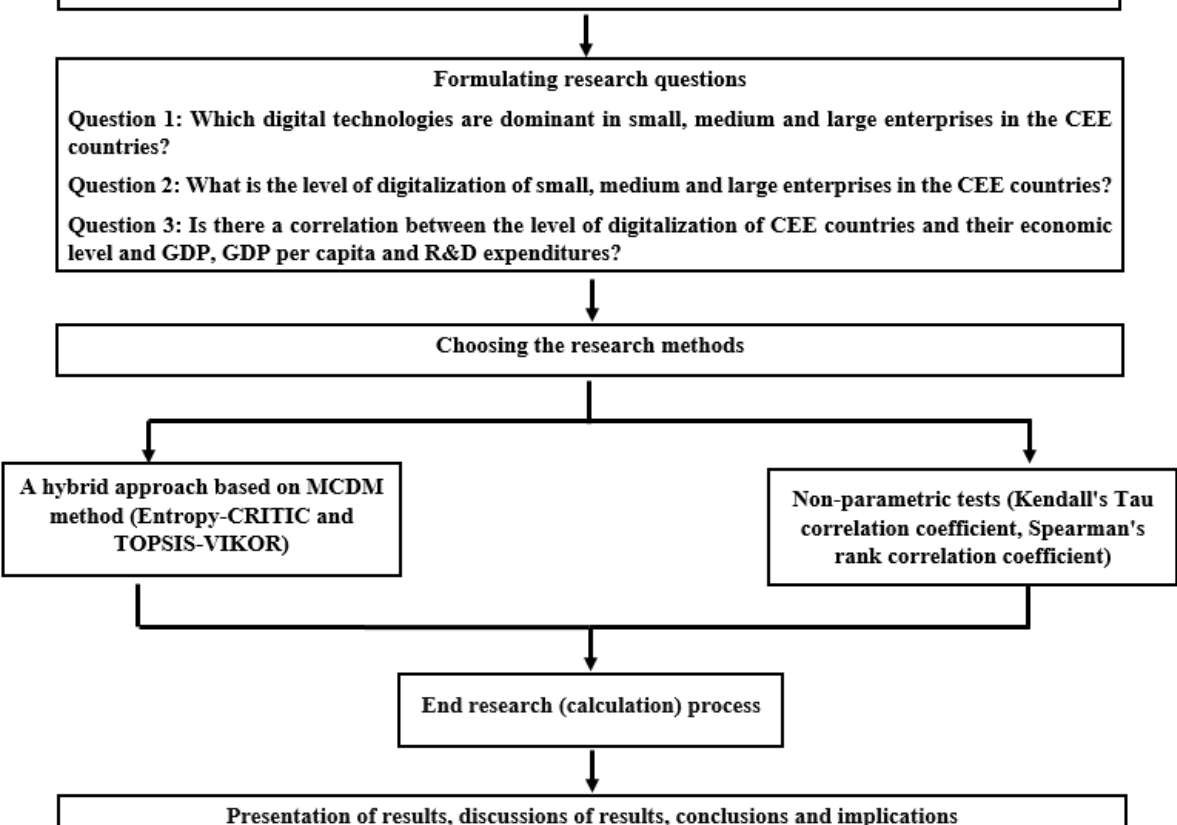
Figure 3. Research procedure.